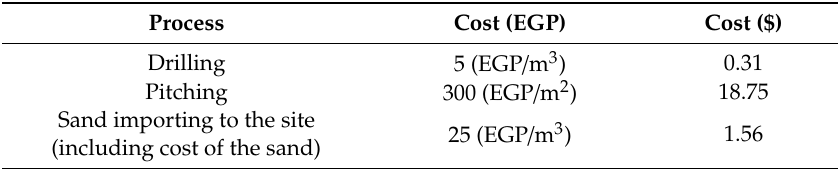
Table 6. Cost estimation per meter per process.